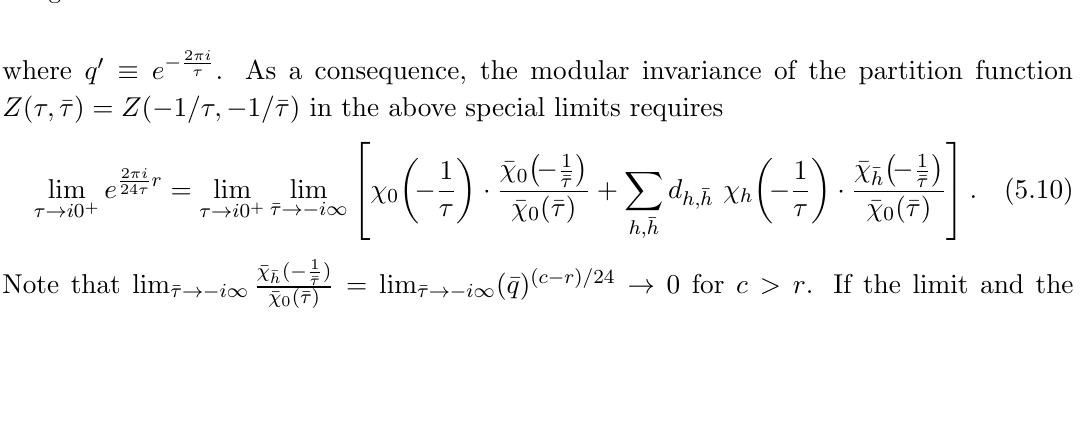
Figure 23. The maximal degeneracies of the lowest primary with various W -algebras and central